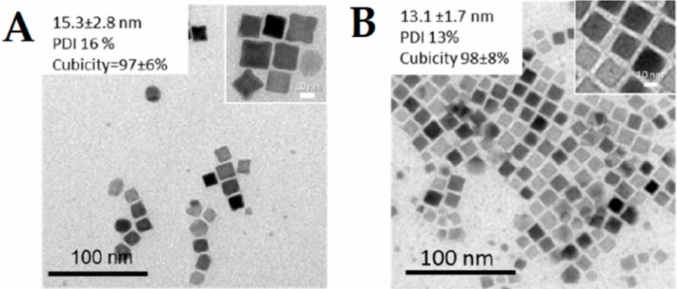
Figure 5. TEM image of ( A ) CoFe 2 O 4 and ( B ) MnFe 2 O 4 nanocubes. Adapted from [126] with permission from American Chemical Society